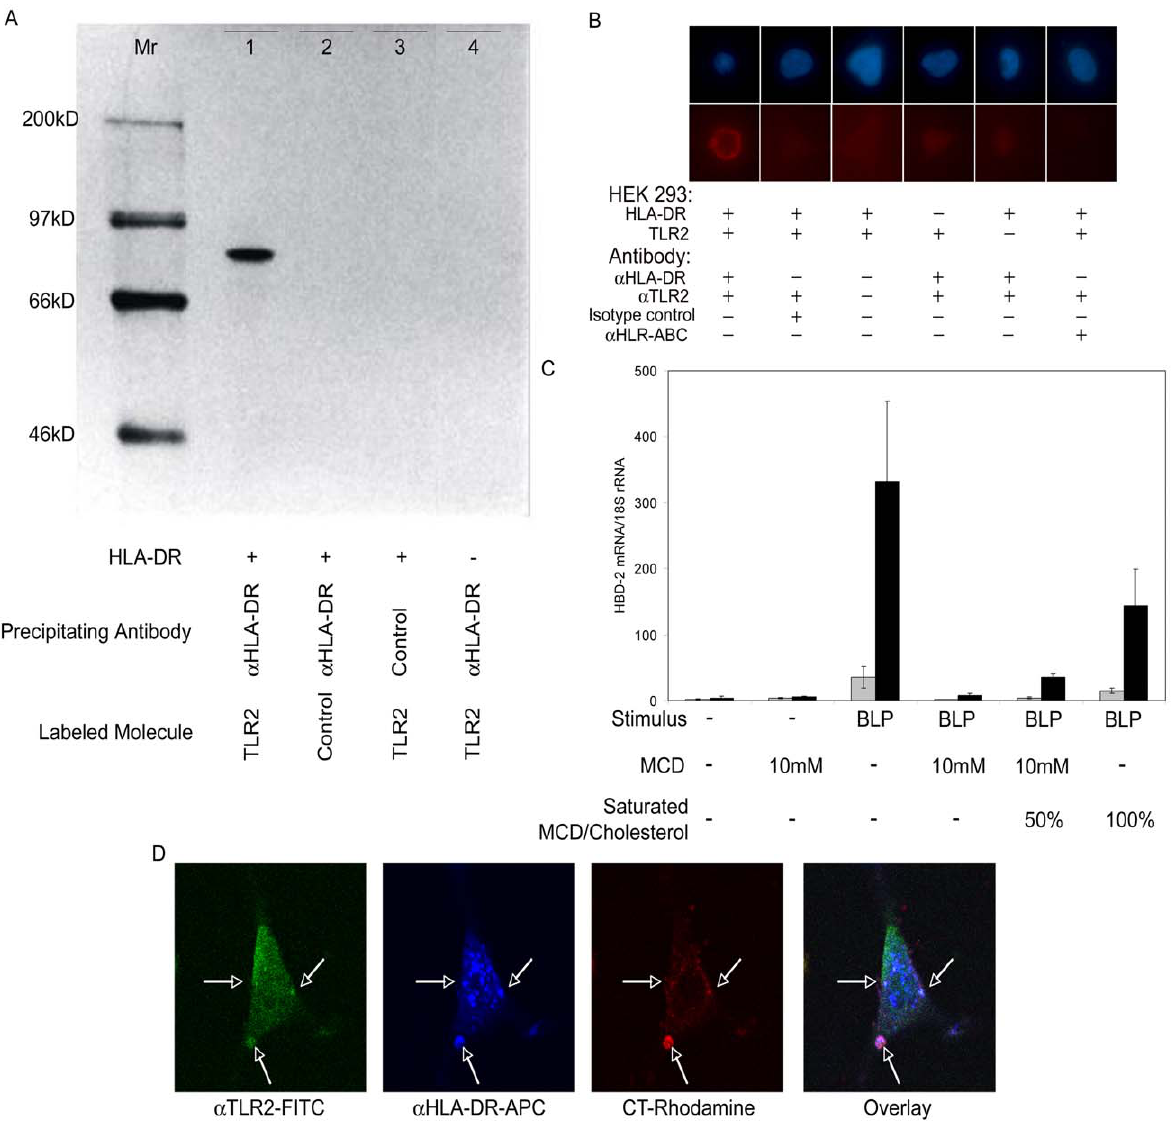
Figure 3. TLR2 and HLA-DR interact physically in lipid raft domains. (A) Co-precipitation of labeled recombinant TLR2 (lane 1, 3, 4) or a control protein (lane 2, luciferase) with HLA-DR molecules purified by immunoprecipitation with anti HLA-DR antibodies (lane 1, 2, 4) or control antibodies (lane 3) from cell lysates of HLA-DR positive (lane 1, 2, 3) or negative (lane 4) HEK293 cells. A 14 C-labeled molecular weight marker (in kD) is shown in the left lane. (B) Proximity ligation assays showed that TLR2 and HLA-DR are close together (red signal), while TLR2 and HLA-ABC do not co- localize (no red signal). Nuclei are stained by Hoechst 33342 (blue). (C) Treatment of TLR2 + (grey bars; n=3) or HLA-DR + /TLR2 + (black bars; n=3) HEK293 cells with MCD, a lipid raft-destroying agent, prior to stimulation with BLP leads to impaired hBD-2 gene expression. The effect is restored via adding MCD saturated with cholesterol acting as cholesterol donor. Error bars represent standard errors. (D) Immunofluorescence microscopy showed that TLR2 ( a TLR2-FITC; green) and HLA-DR ( a HLA-DR-APC-Cy9; blue) co-localize in lipid raft domains (CT-rhodamine; red) of HLA-DR + /TLR2 + HEK293 cells (indicated by the white arrows). Pictures are representatives of at least five experiments. doi:10.1371/journal.pone.0008808.g003 with an empty pCEP4 plasmid (Invitrogen), a pUNO-hTLR2/4/7 plasmid (InvivoGen), or with three plasmids coding for each chain of HLA-DR lacking the intracellular tail using the TransIT-293 Transfection Reagents (Mirus). Cells were grown in DMEM (Gibco BRL) supplemented with 10% low endotoxin FBS (Hyclone) and 1% of an antibiotic-antimycotic solution (Gibco BRL). Depending on the resistance genes present, medium was supplemented with additional selection antibiotics G418, Hygro- mycin (Roche Diagnostics), Ouabain (Sigma), or Blasticidin (InvivoGen).